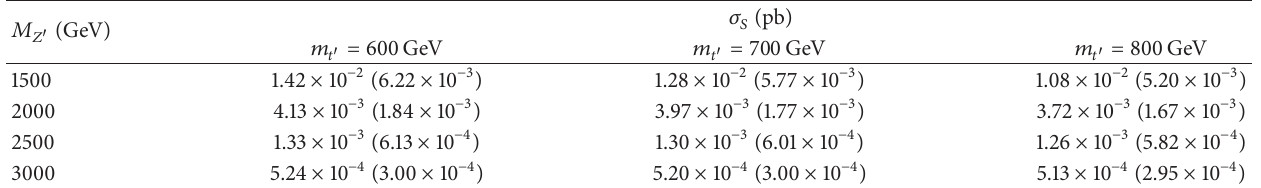
Table 7: The total cross section values for the signal ( 𝜎 𝑆 ) are calculated for the process 𝑝𝑝 → (𝑊 + 𝑏𝑡+𝑊 − 𝑏𝑡)+𝑋 at the LHC with √𝑠 = 13 TeV. The results are obtained for the 𝑍 󸀠 𝜓 model (the 𝑍 󸀠 LP model) and the FCNC parameter 𝑥 = 0.01 . 𝑀 𝑍 󸀠 (GeV)